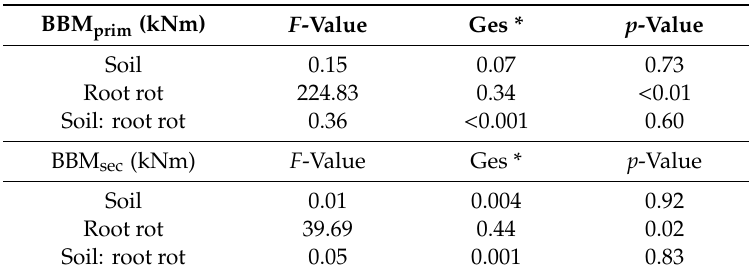
Table 3. Results of the fractional analysis of variance between bending moment at primary (BBM prim ) and secondary (BBM sec ) failure, soil type, the presence of root rot, and the interaction between soil type and the presence of root rot.